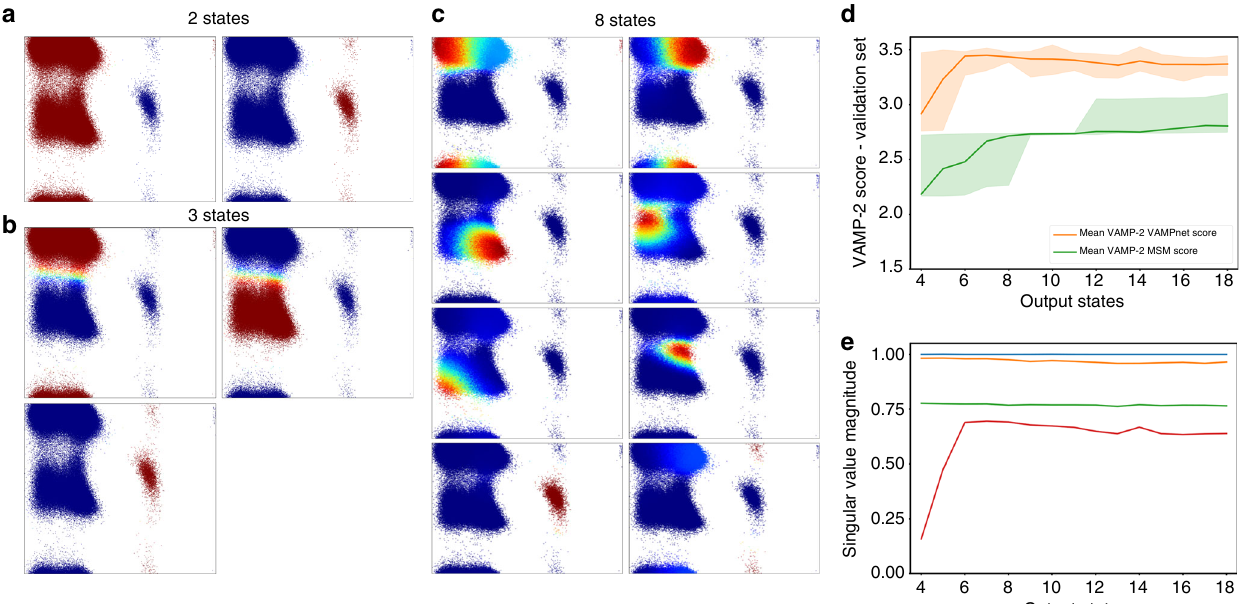
Fig. 5 Kinetic model of alanine dipeptide as a function of the number of output states. a – c Assignment of input coordinates, plotted as a function of ϕ and ψ , to two, three, and eight output states. Color corresponds to activation of the respective output neuron, indicating the membership probability to this state (Fig. 4b). d Comparison of VAMPnet and MSM performance as a function of the number of output states/MSM states. Mean VAMP-2 score and 95% con fi dence interval from 100 runs are shown. e Mean squared values of the four largest singular values that make up the VAMPnets score plotted in